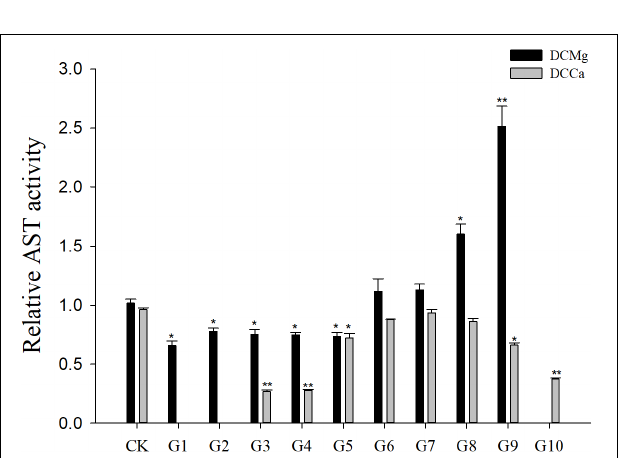
FIGURE 8 | Relative LZM activity of JSCs under long-term stress with different Ca 2 + and Mg 2 + concentrations. Results show LZM activity at 30-days normalized to the 0-day. Bars (mean ± SE, n = 3) with an asterisk denote a significant difference ( ∗ P < 0.05, ∗∗ P < 0.001) between the test groups (G1–G10) and